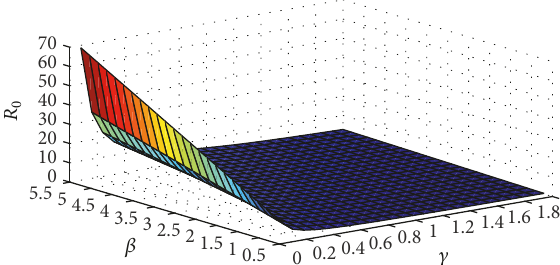
Figure 4: Variation of the basic reproduction number ( 𝑅 0 ) with respect to rate of contact ( 𝛽 ) and 𝛾 .